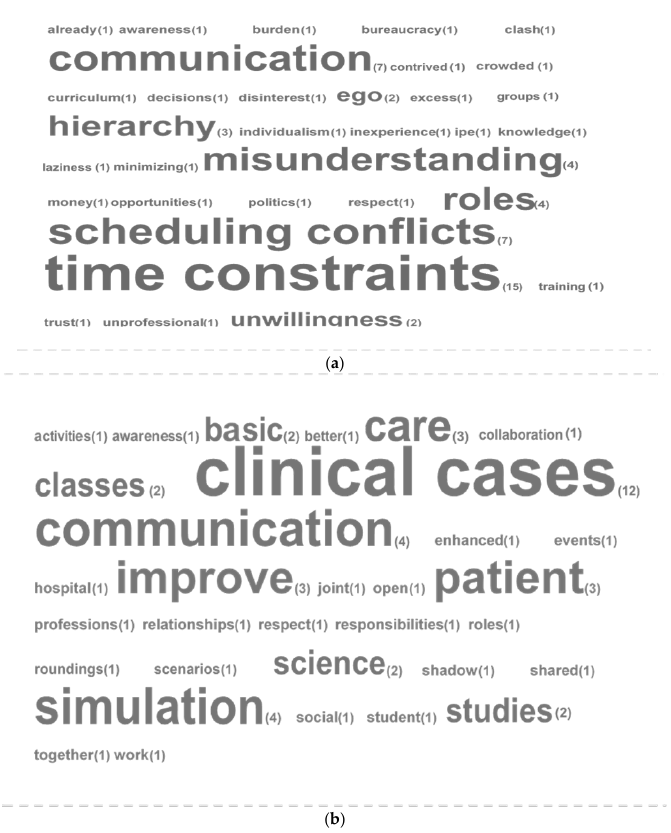
Figure 2. ( a ) TagCrowd analysis of IPE barriers, as perceived by the medical students ( b ) TagCrowd analysis of IPE opportunities, as perceived by the medical students. analysis of IPE opportunities, as perceived by the medical